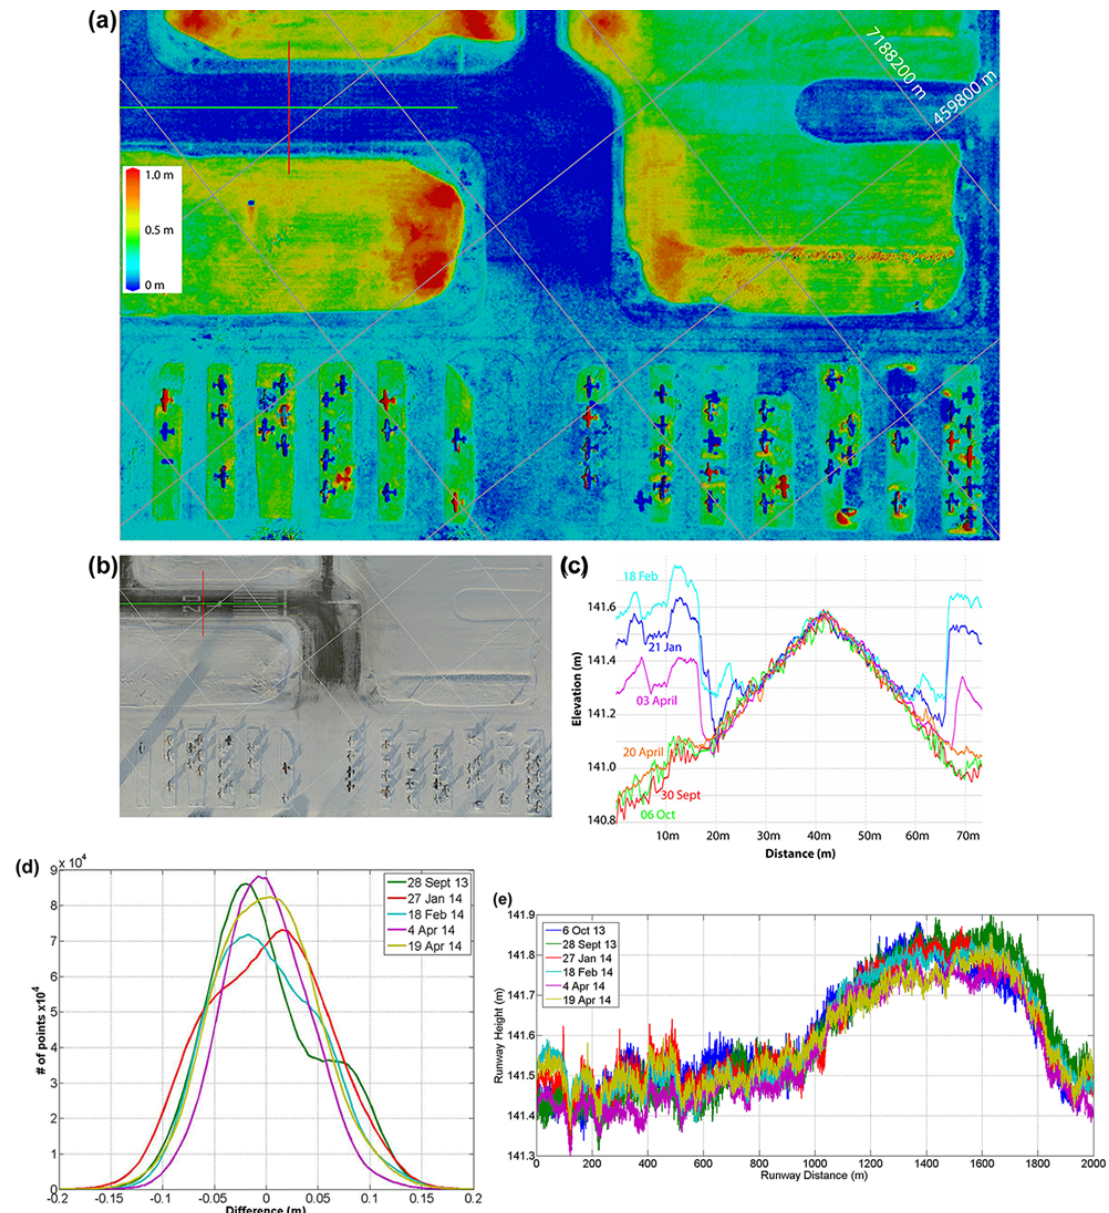
Figure 2. (a) A difference map (21 January 2014 minus 6 October 2013) produced by our technique shows centimeter-scale detail in the complex snow depth fields found at the Fairbanks International Airport in mid-winter (b) . The UTM 6N graticule is overlaid at 100m spacing in (a) and (b) . The natural accumulation level of about 43cm (green) can be seen in all undisturbed areas, such as the grassy infields near the runways and in between the small airplanes where the trucks have not plowed. The main runway is plowed throughout the winter and shows little to no change (dark blue) but the parking ramp holds packed snow 10–12cm deep (light blue) to allow ski plane access. Plowing has piled up snow to over 1m around the edges of the runway (yellow and red). Subtle striping seen in the infields is real and comes from the summer DEM; it is the pattern left in the grass by mowing. Not all indicated changes are due to snow: airplanes that have moved saturate the color scale with changes up to ± 2m. In (c) we have produced cross-runway profiles from a time series of six maps made in 2013–2014 along the red transect shown in (a) . Over most of the plowed runway, the scatter between measurements is ± 3cm, allowing us to clearly resolve accumulations on the edges of the runway of centimeters to decimeters. (d) Histograms of the differences between five maps and the reference map of 6 October 2013 for only the snow-free runway pixels show a roughly normal distribution, each with 95% of points with ± 10cm. The excursions from normal distribution are likely caused by remnant snow/ice and the fact that the runways experience real elevation changes between mapping dates from frost heave. (e) We examined elevations from each map along a transect down the centerline of the runway (green line in (a) , which extends the length of the runway) with 95% of the range of scatter within ± 6cm.